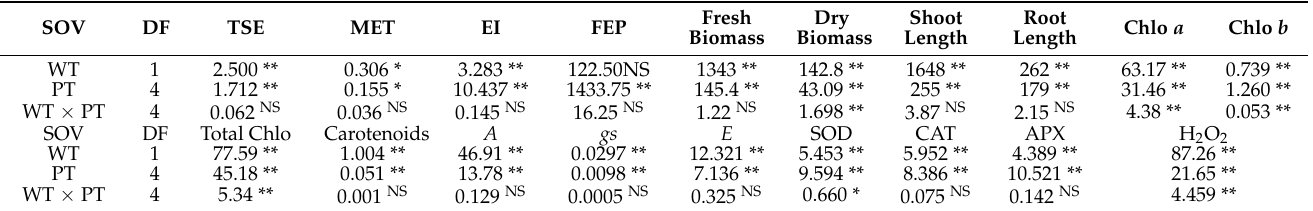
Table 1. Analysis of variance for emergence, growth, photosynthetic pigment, gas exchange and enzymatic attributes of rice seedlings cultivated under normal and water deficit regimes in response to priming treatments of moringa leaf extracts (n = 4).